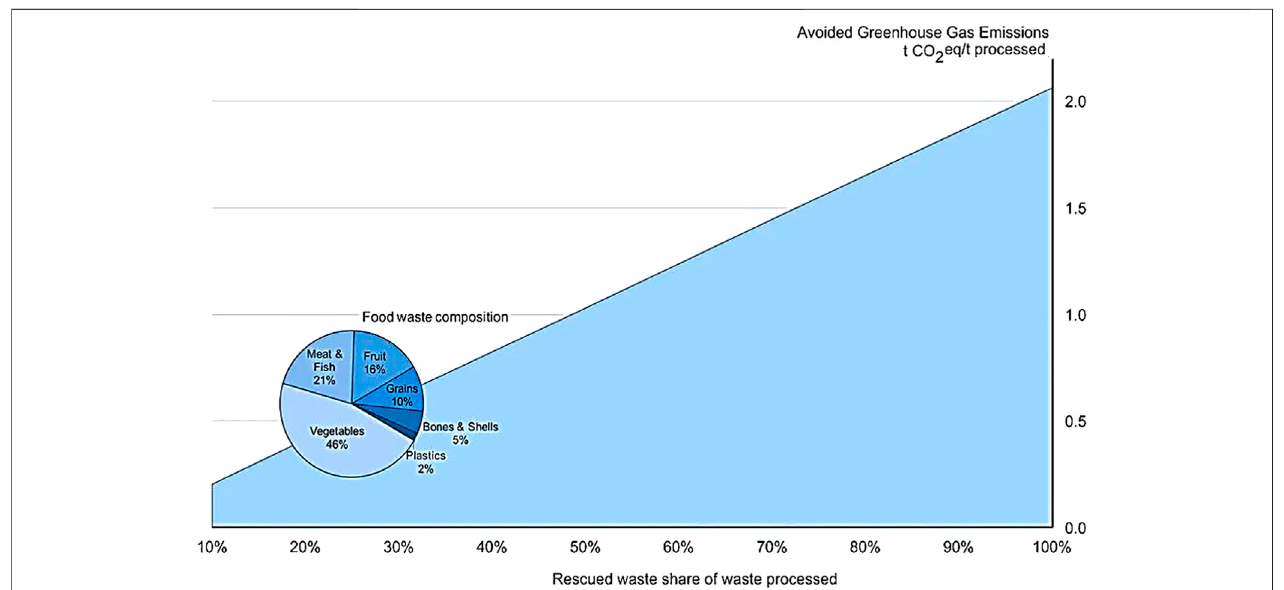
FIGURE 2 | Carbon dioxide mitigation potential per tonne processed food waste as a function of fraction diverted into various processes instead of land fi lling, calculated with WBCSD ’ s Food Loss and Waste Value Calculator (Quantis 2019) with composition of FW (vegetables, meat and fi sh, fruit, grains, bones and shells, and plastics) selected to assess the avoided emissions throughout this study (food waste composition for South East Asia (Paudel et al., 2017)).